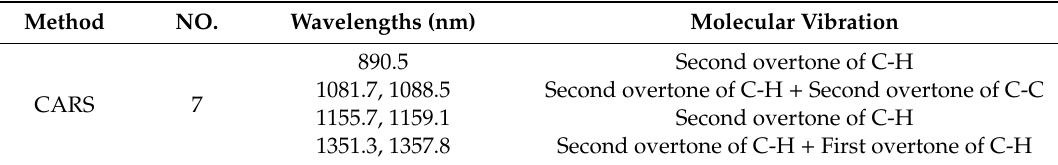
Figure 8. Process of selecting characteristic wavelengths based on competitive adaptive reweighted sampling (CARS). Table 3. The characteristic wavelengths and the corresponding molecular vibration extracted by competitive adaptive reweighted sampling (CARS).